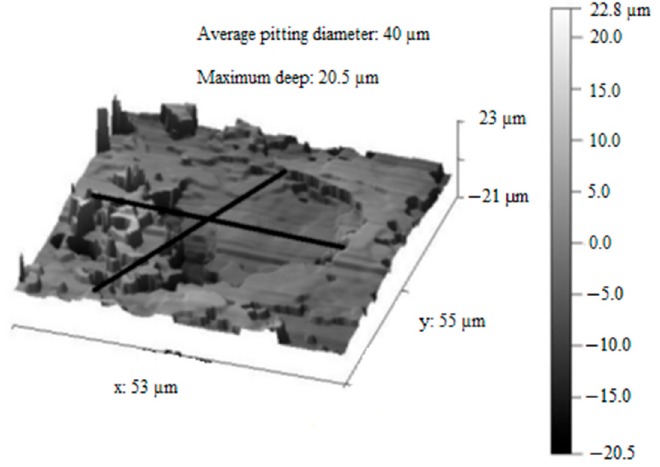
Figure 3. Two-dimensional digital image of a pit of the sample corroded during two months (C2) obtained by confocal microscopy. Pit depth and mean diameter were determined by Sensomap software.